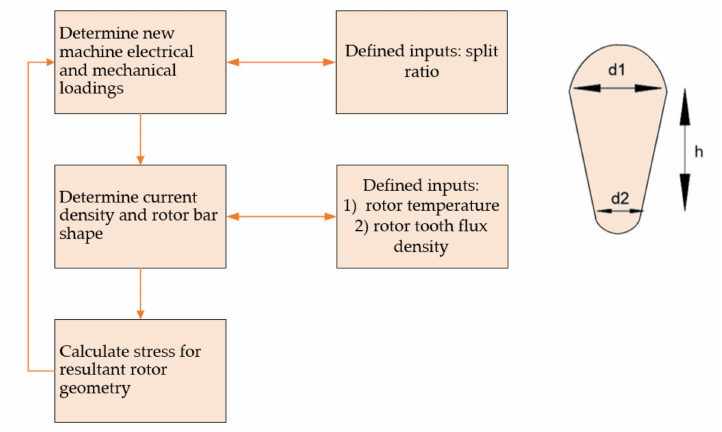
Figure 6. Suggested design methodology ( left ) and drop-shaped bar used ( right